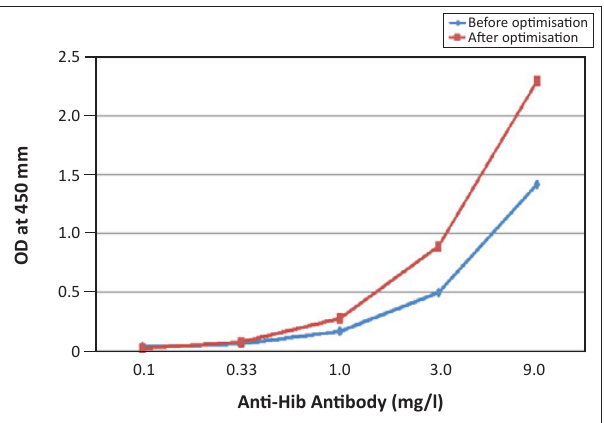
FIGURE 2: VaccZyme™ Anti-Hib enzyme-linked immunosorbent assay calibration curves before and after